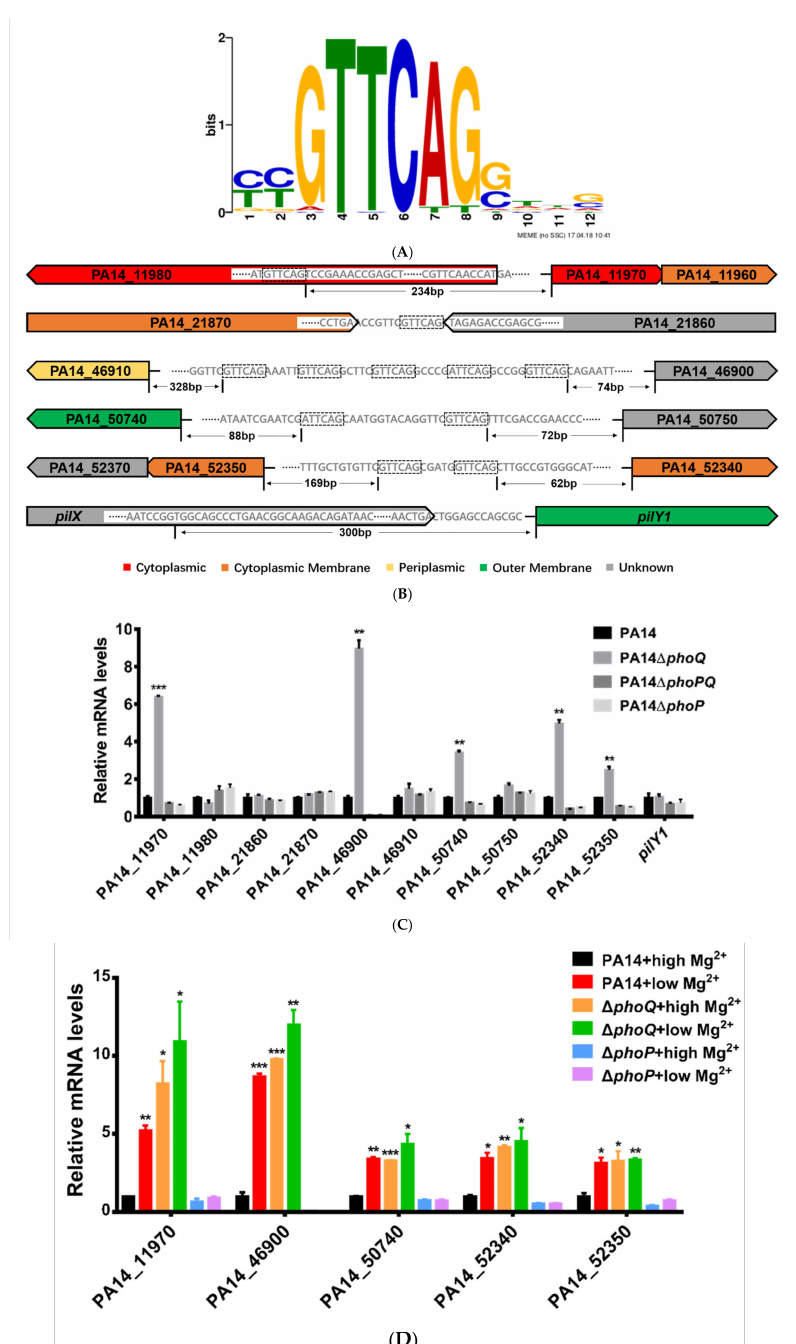
Figure 1. Genes controlled by the PhoP-PhoQ two-component regulatory system. ( A ) Potential PhoP binding motif was identified by MEME from the ChIP-seq peak regions. ( B ) Locations of the enriched peaks on the PA14 chromosome. The predicted phoP binding sequences are boxed. Colors of the genes were adopted from the Pseudomonas Genome Database (www.pseudomonas.com). ( C ) The wild-type PA14, ∆ phoP , ∆ phoQ , and ∆ phoP ∆ phoQ mutants were grown to an OD 600 of 1.0. The mRNA levels of the indicated genes were determined by quantitative real time PCR. ( D ) The wild-type PA14, ∆ phoP , and ∆ phoQ mutants were grown to an OD 2+ (2 mM) and low Mg 2+ 600 of 1.0 in the BM2 medium with high Mg (2 µ M). The mRNA levels of the indicated genes were determined by quantitative real time PCR. Data represents mean ± standard deviation. *, p < 0.05; **, p < 0.01; ***, p < 0.001 by Student’s t